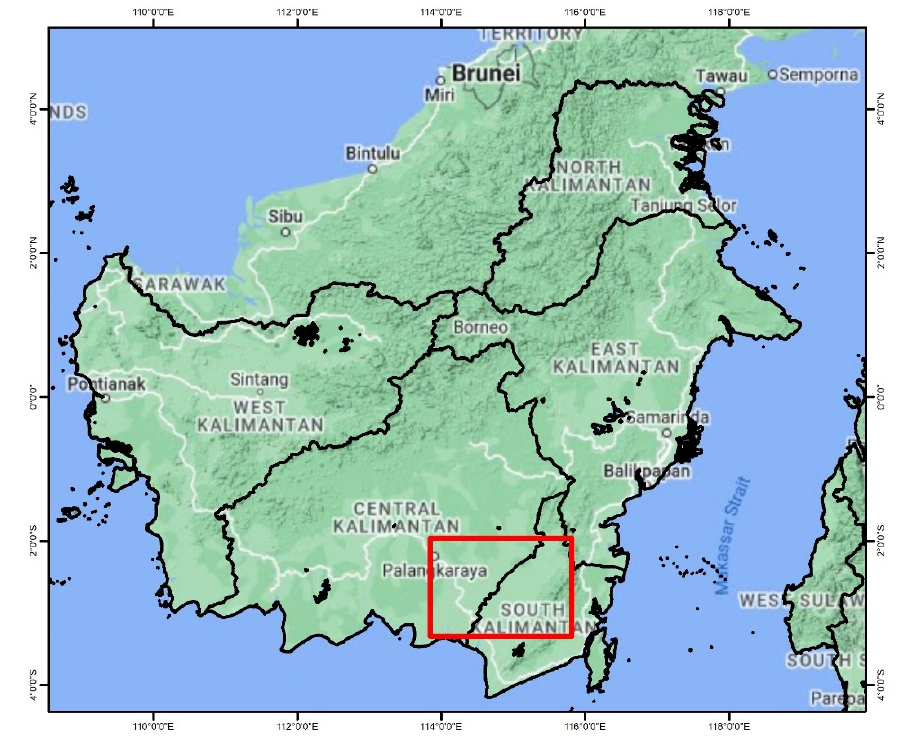
Figure 1. Areas of interest/sampling areas on Kalimantan island.